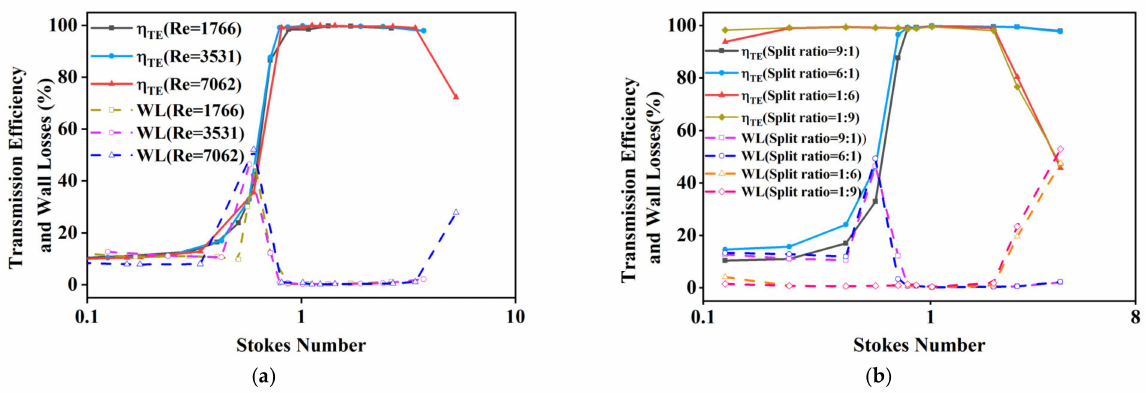
Figure 8. ( a ) Influence of Reynolds number on sampler performance ( b ) Impact of split ratio on sampler